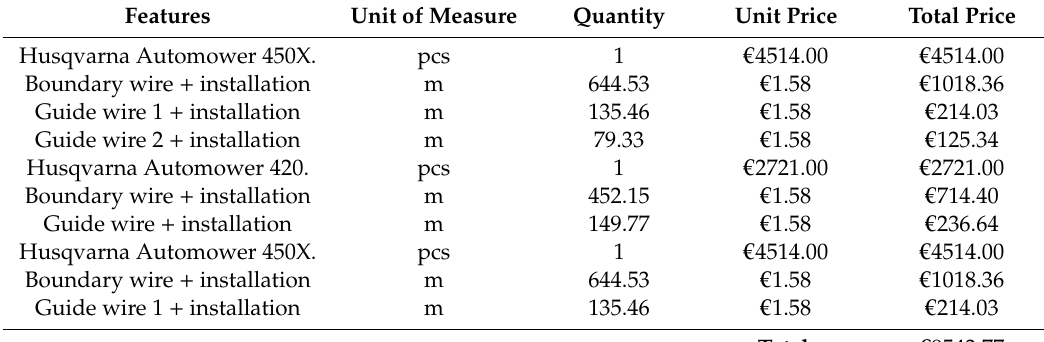
Table 4. Total cost of Scenario 1.